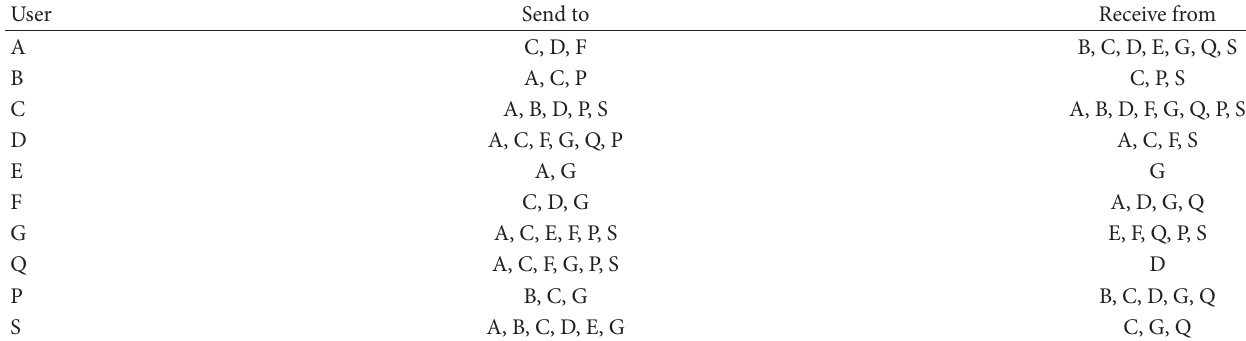
Table 2: Application of media mixing algorithm on user’s